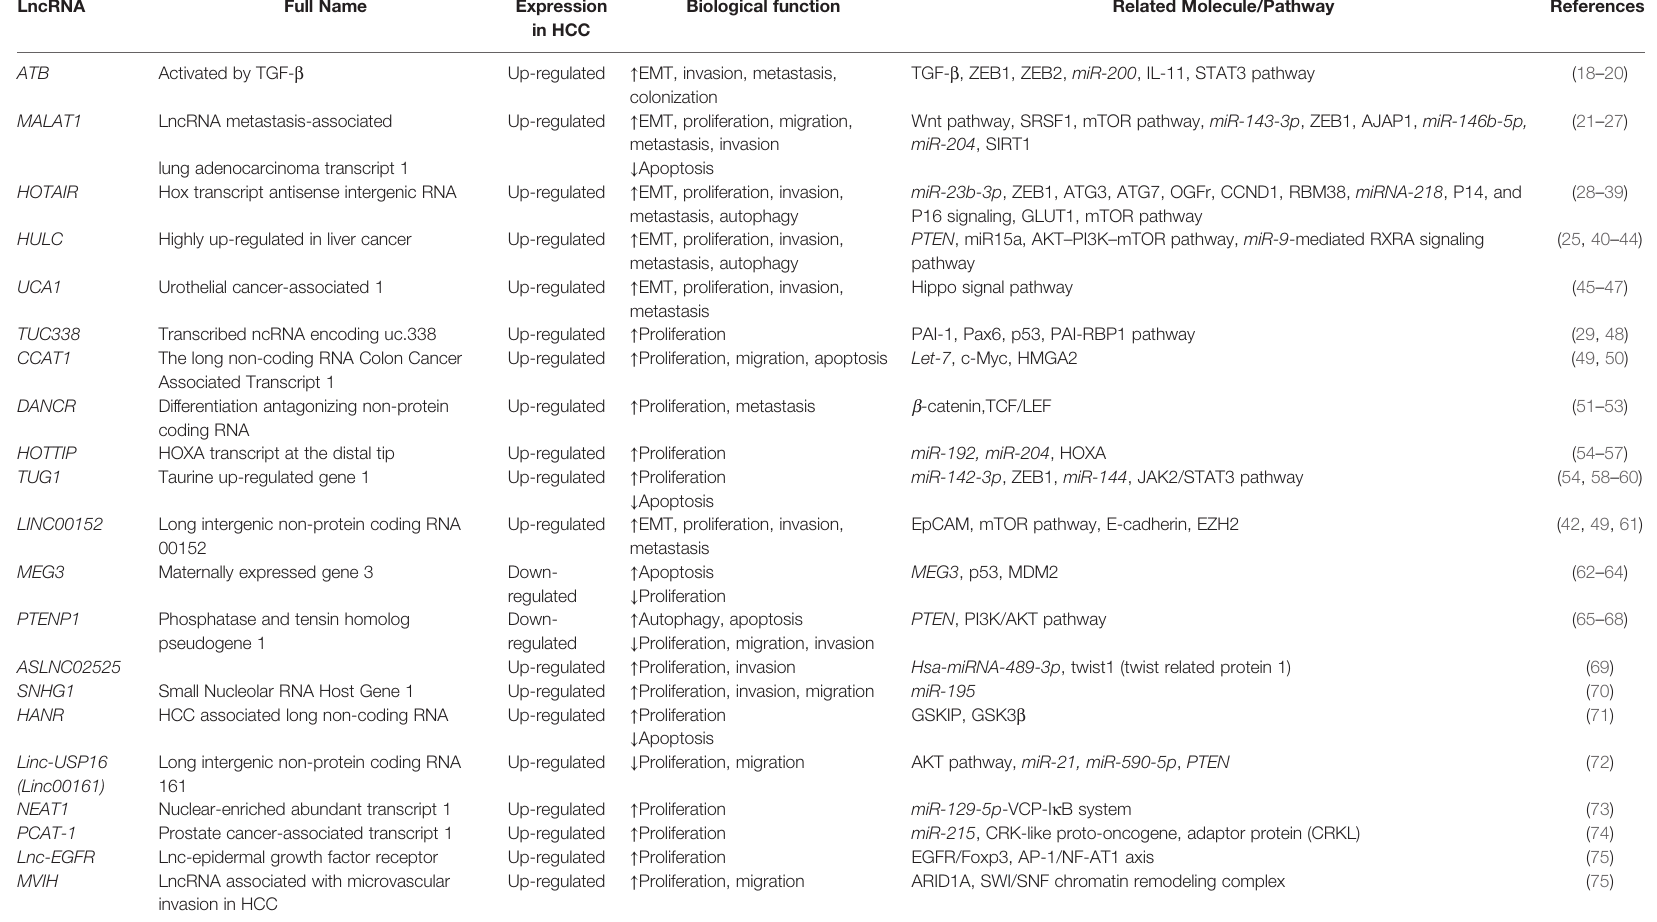
TABLE 2 | Dysregulated lncRNAs in HCC, their biological functions, and related